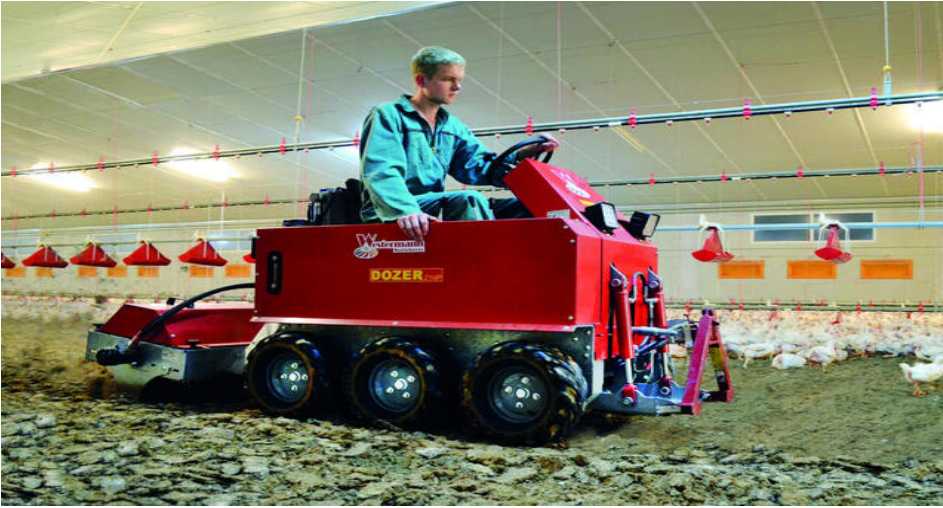
Figure 5. Mulching of slabs in a broiler housing facility. Source: Hiller, P., 2018 [12].